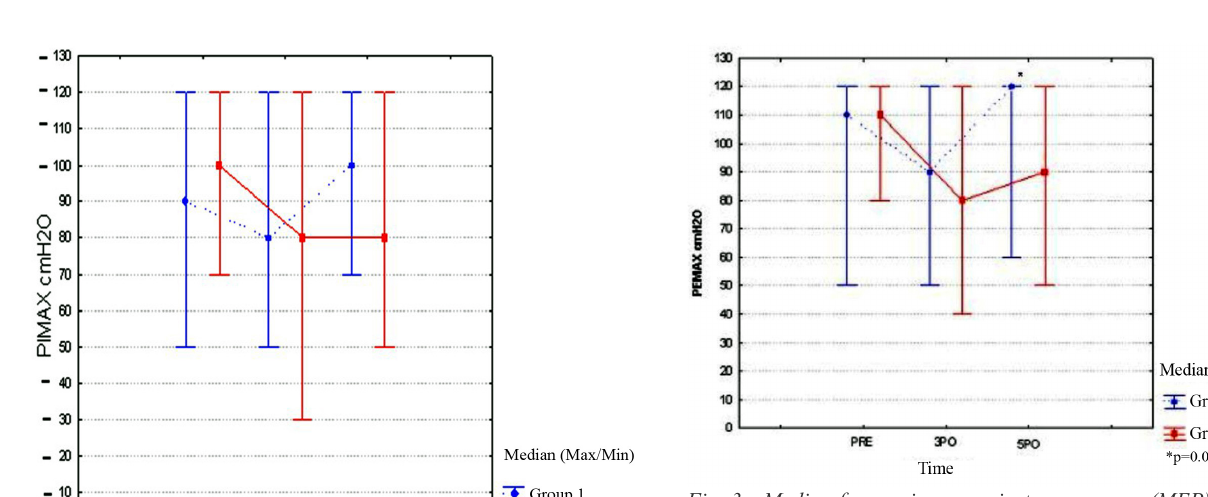
Fig. 3 - Median for maximum expiratory pressure (MEP) variable at different times of the operation in the different groups. Friedman test for comparison of moments in each group and Mann Whitney test to compare the groups at each time, *P<0.05.